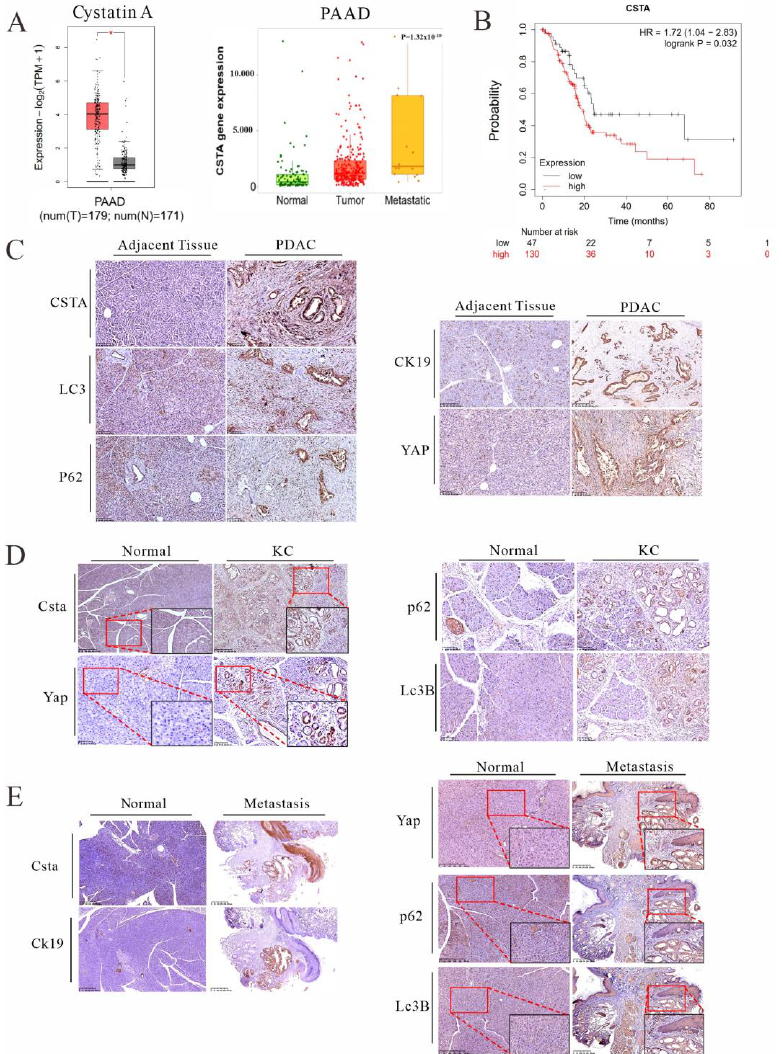
Figure 5. A high level of cystatin A expression, an indication of lysosomal stress, is associated with malignant progression of pancreatic cancer. ( A ) Boxplot analysis (left) of CSTA expression in pan- creatic tumors (T) and normal regions (N) based on the GEPIA2 database (http://gepia2.cancer- pku.cn/, 19/12/2021). Comparison of CSTA expression profiles (right) in normal, pancreatic adeno- carcinoma (PAAD), and metastatic tissues based on the TNMplot database (https://tnm- plot.com/analysis/,19/12/2021). ( B ) Kaplan–Meier survival analysis of CSTA expression in pancre- atic cancer based on the Kaplan–Meier Plotter database (http://kmplot.com/analysis/,19/12/2021). ( C ) IHC staining of human pancreatic tissues of normal adjacent and PDAC specimens for CSTA (scale bars = 100 μm), YAP (scale bars = 100 μm), P62 (scale bars = 100 μm), LC3 (scale bars = 100 μm), and CK19 (scale bars = 250 μm). ( D ) IHC staining for Csta (scale bars = 250 μm), Yap (scale bars = 100 μm), p62 (scale bars = 100 μm), and Lc3B (scale bars = 100 μm) in the pancreas of normal and KC mice. ( E ) IHC staining for Csta, Ck19, Yap, p62, and Lc3B in normal mouse pancreas and KC mouse metastasis. Scale bars = 250 μm. Representative images of IHC staining were shown.